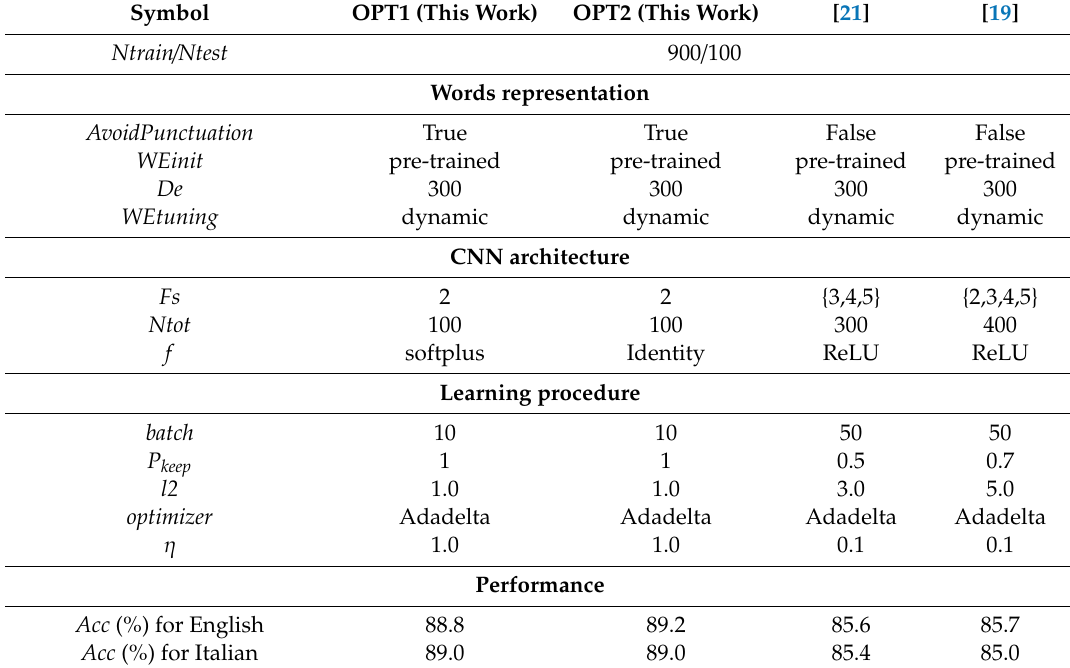
Table 18. Testing accuracy for optimal settings, averaged on experiments repetitions, and for settings individuated in previous